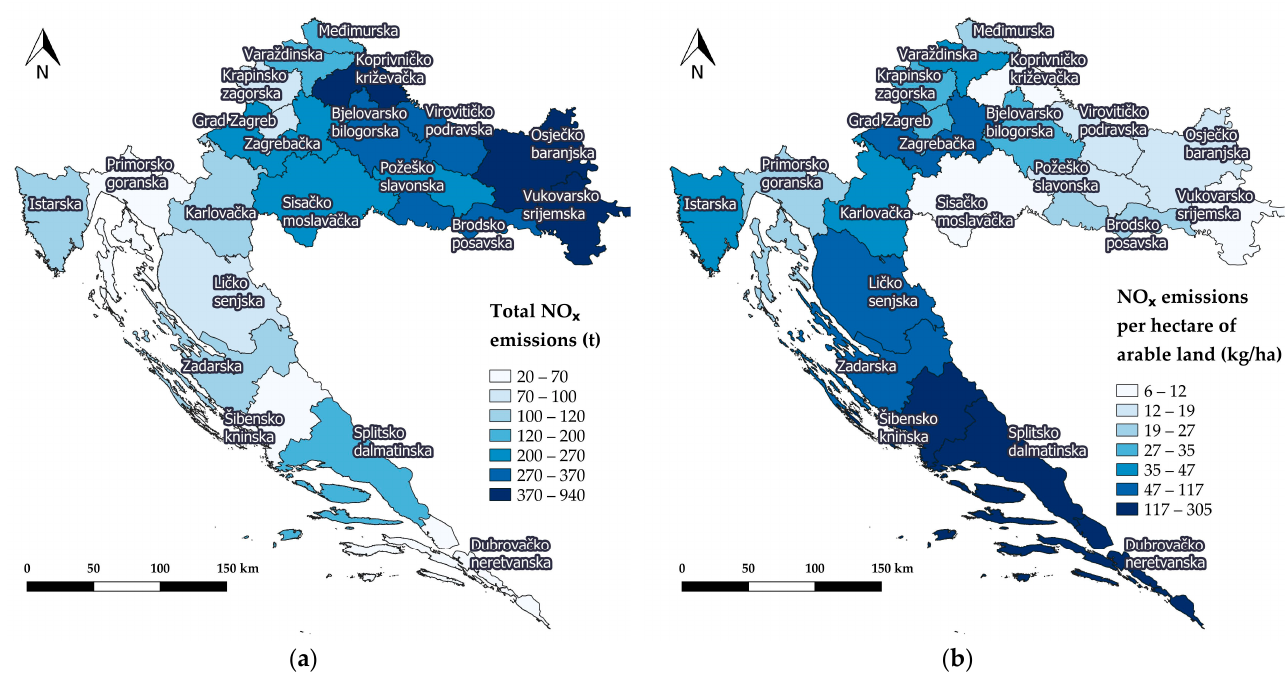
Figure 7. Spatial distribution of total hydrocarbon (HC) emissions ( a ) and spatial distribution of HC emissions per hectare of arable land ( b ).